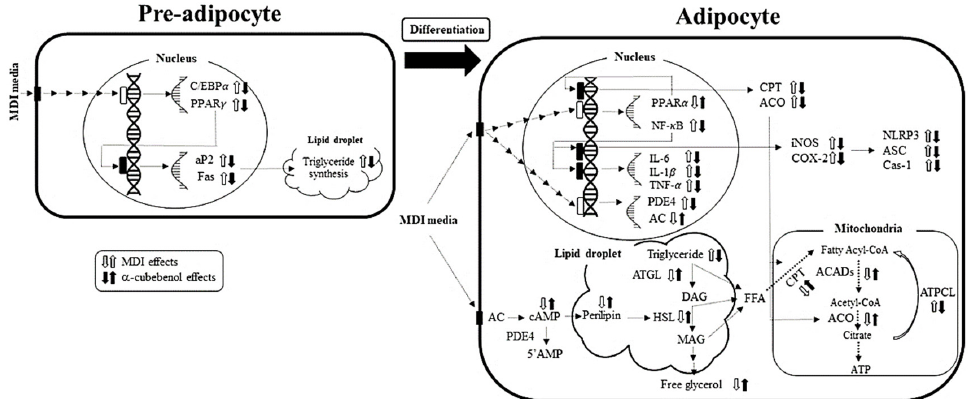
Figure 9. The proposed mechanism of α -cubebenol on anti-obesity effects in pre-adipocytes and adipocytes. During differentiation from pre-adipocytes to adipocytes, response stimulated by MDI are inhibited or promoted by α -cubebenol treatment. Schematic diagram of the lipogenesis and lipolysis procedure, Figure S2: Determination of the optimal concentration of CN and cytotoxicity assessment, Figure S3: Apoptosis analysis of 3T3-L1 pre-adipocytes, Table S1: Primer sequences for RT-PCR, Table S2: Antibodies list for Western blot